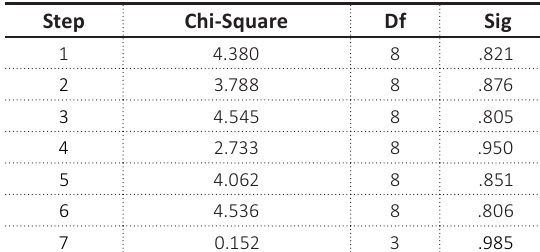
Table 9. Hosmer-Lemeshow test